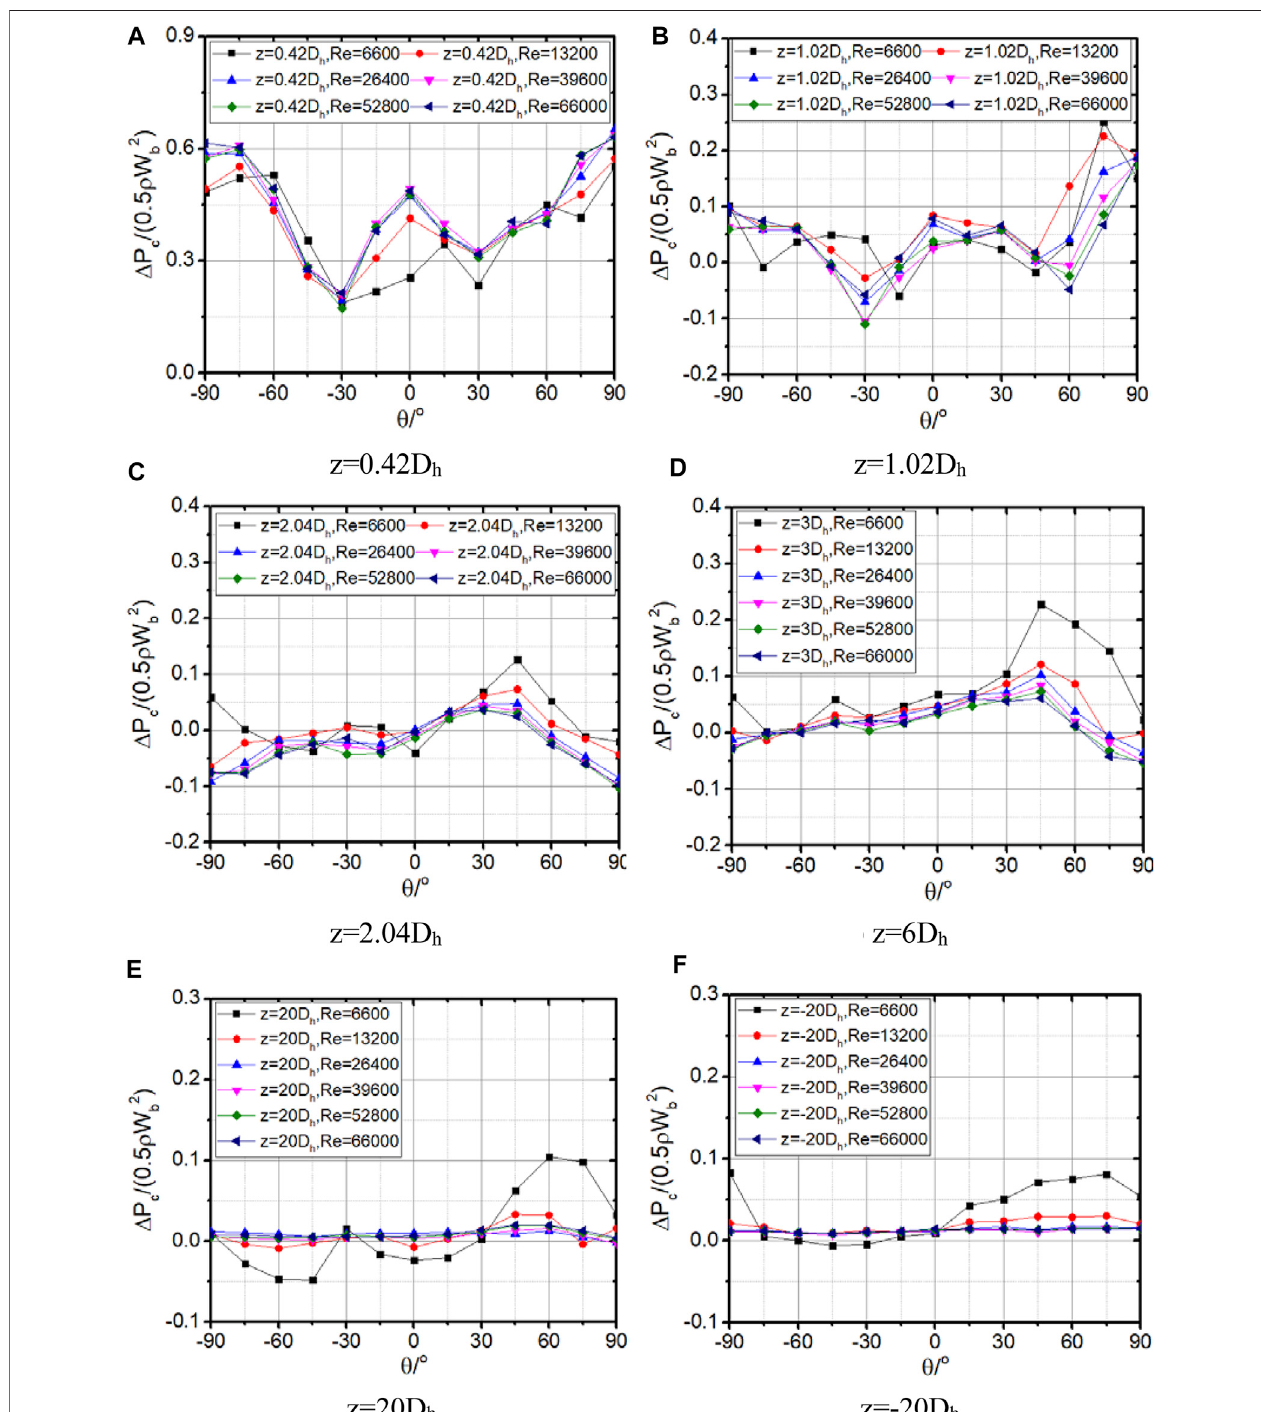
FIGURE 10 | Normalized lateral pressure loss with